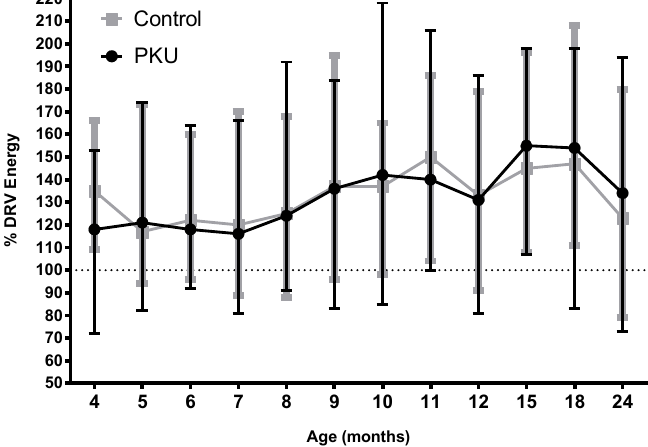
Figure 8. Mean % dietary reference values (DRV) for Energy for PKU and control groups by age. 3.8. Percentage of Energy from Carbohydrate, Fat and Protein PKU vs. Control (Includes Energy Intake from Food)